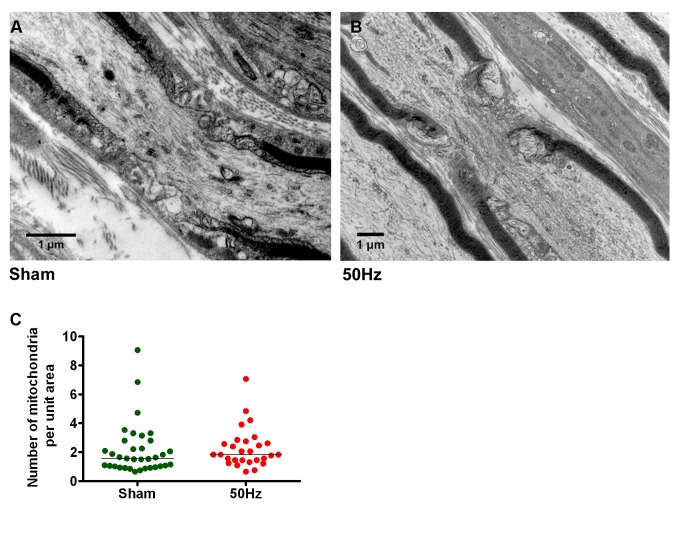
Mitochondria do not accumulate in the vicinity of Nodes of Ranvier.(A and B) Nodes of Ranvier in sham-stimulated (n = 35) and axons stimulated at high frequency (50 Hz, n = 28) appeared similar upon ultrastructural examination (bar = 1 µm), and (C) possessed similar numbers of mitochondria (p = 0.22, Mann-Whitney test).